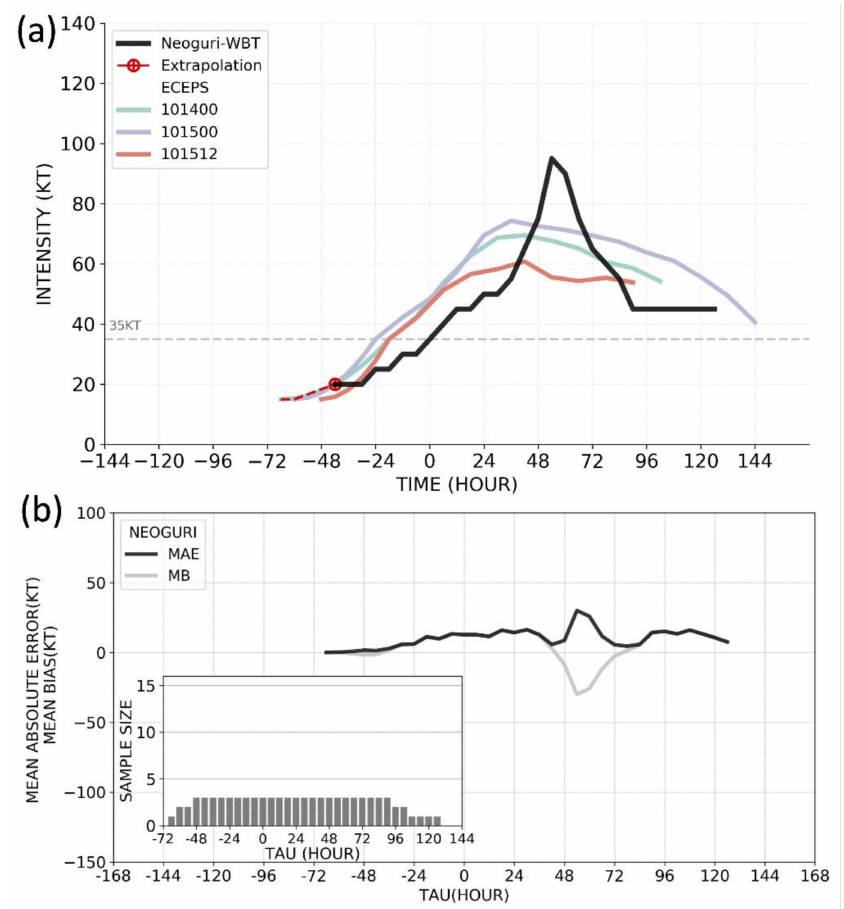
Figure A2. ( a ) Modified WAIP intensity (knots) forecast verifications for the ECEPS-predicted T2F (35 kt) as in Figure 5a, except for the pre-TY Neoguri (2019) circulations. ( b ) Intensity MAEs (solid line) and intensity MBs (gray line) as in Figure 5b, except for pre-TY